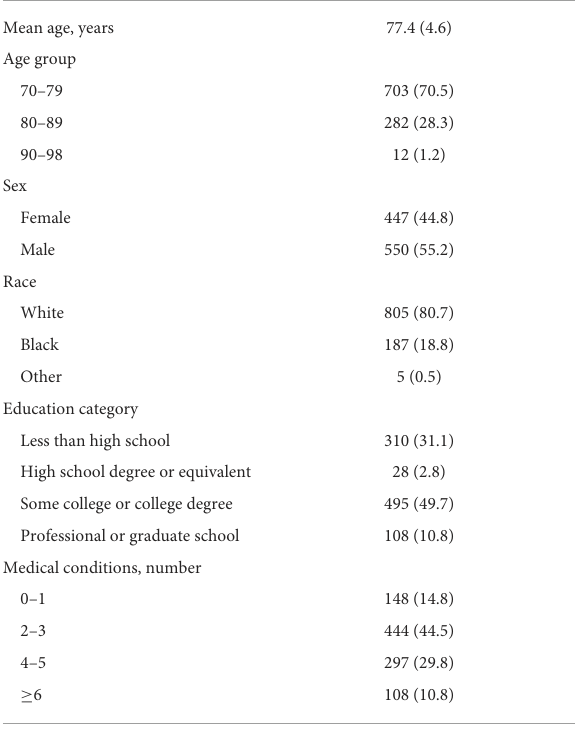
TABLE 3 Visual function and Rasch person abilities for dashboard domains of